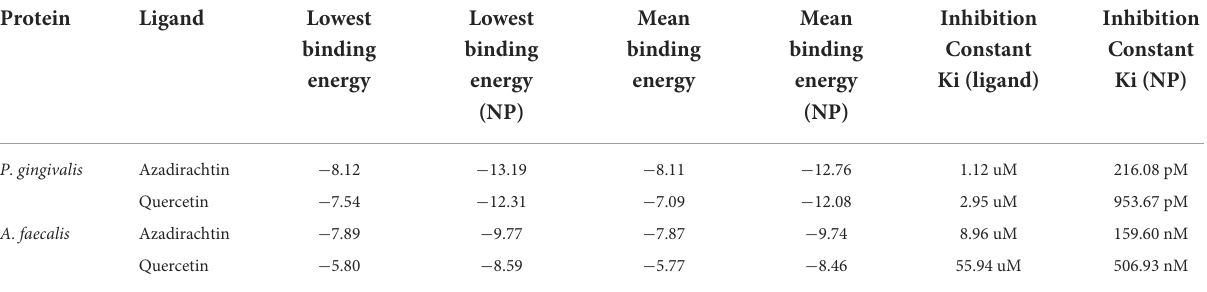
TABLE 5 The binding energy values of molecular docking